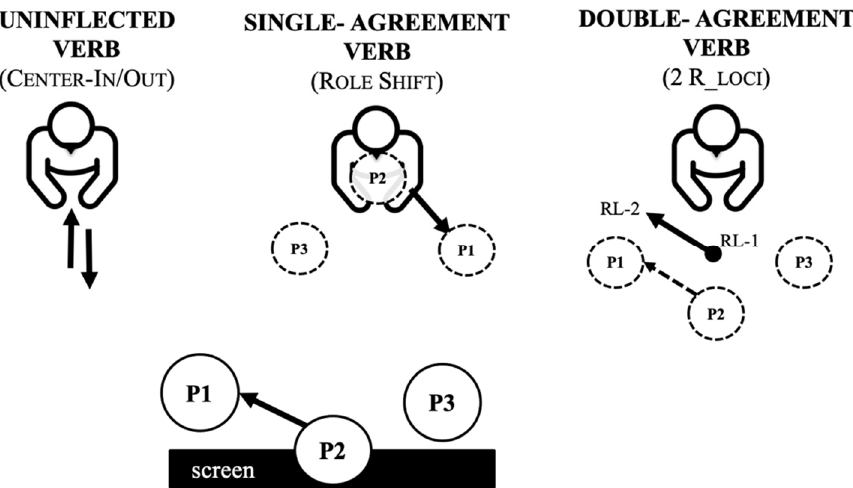
Figure 4. Representation of the three verb types used by participants in the task. The diagrams represent the signers and the signing area as viewed from above. The circles with P1, P2 and P3 indicate where the signers created R-Loci (RL) and the arrows represent the movement of the sign performed in the signing space. This representation is based on the action presented in a video clip on the screen (represented by a black line in the bottom of the image).